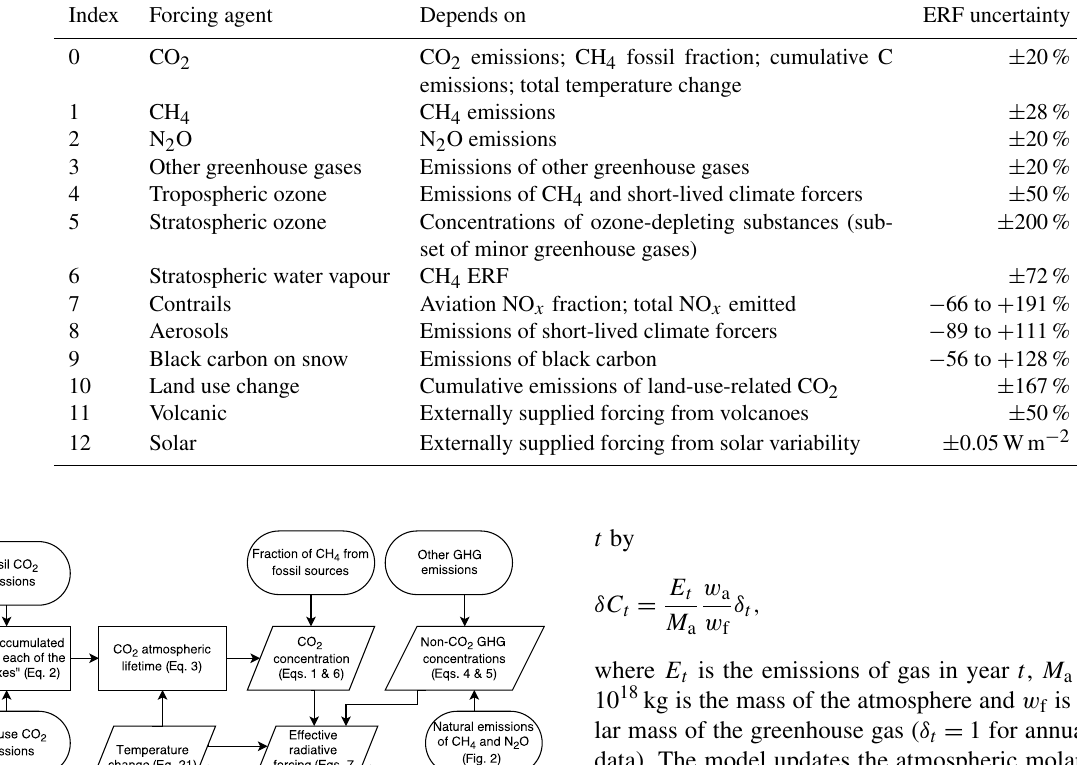
Table 3. The 13 separate forcing groups considered in FAIR v1.3 in the calculation of effective radiative forcing. The ERF uncertainty represents the 5–95% range and is used in the generation of the large ensemble (Sect. 3). ERF uncertainties from Myhre et al. (2013b) are used except for CH 4 where we use the Myhre et al. (2013b) estimate inflated by the additional uncertainty in the new methane forcing relationship in Etminan et al. (2016), which also affects the uncertainty in stratospheric water vapour oxidation from methane.